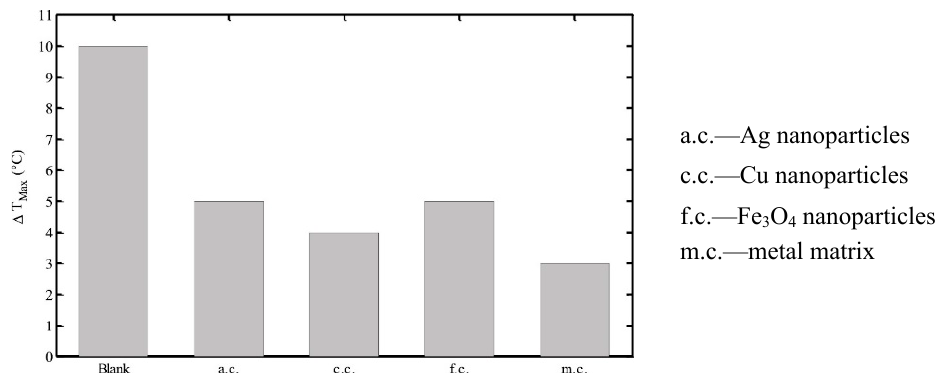
Figure 7. Maximum temperature difference between the simulator surface and the composite PCM [46]. Reproduced with permission from Elsevier.